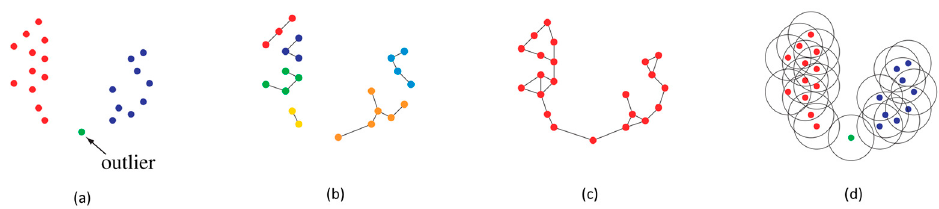
Figure 10. The difference between KNN and RBNN in cluster ability. Subfigure (a) shows the data set with 2 clusters and 1 outlier, (b) shows 1-NN graph yielding 6 clusters, (c) shows 2-NN graph yielding 1 cluster and subfigure (d) displays RBNN graph yielding 2 clusters and 1 outlier.